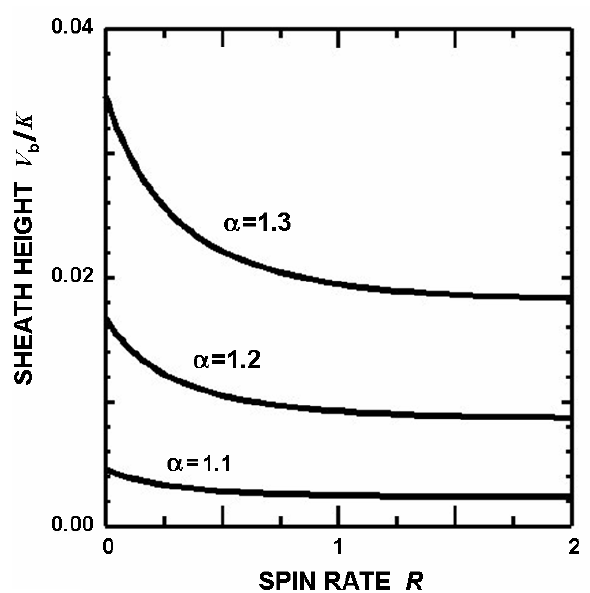
Fig. 7. The normalized photoemission sheath barrier height, V b / K , at φ b , versus R .